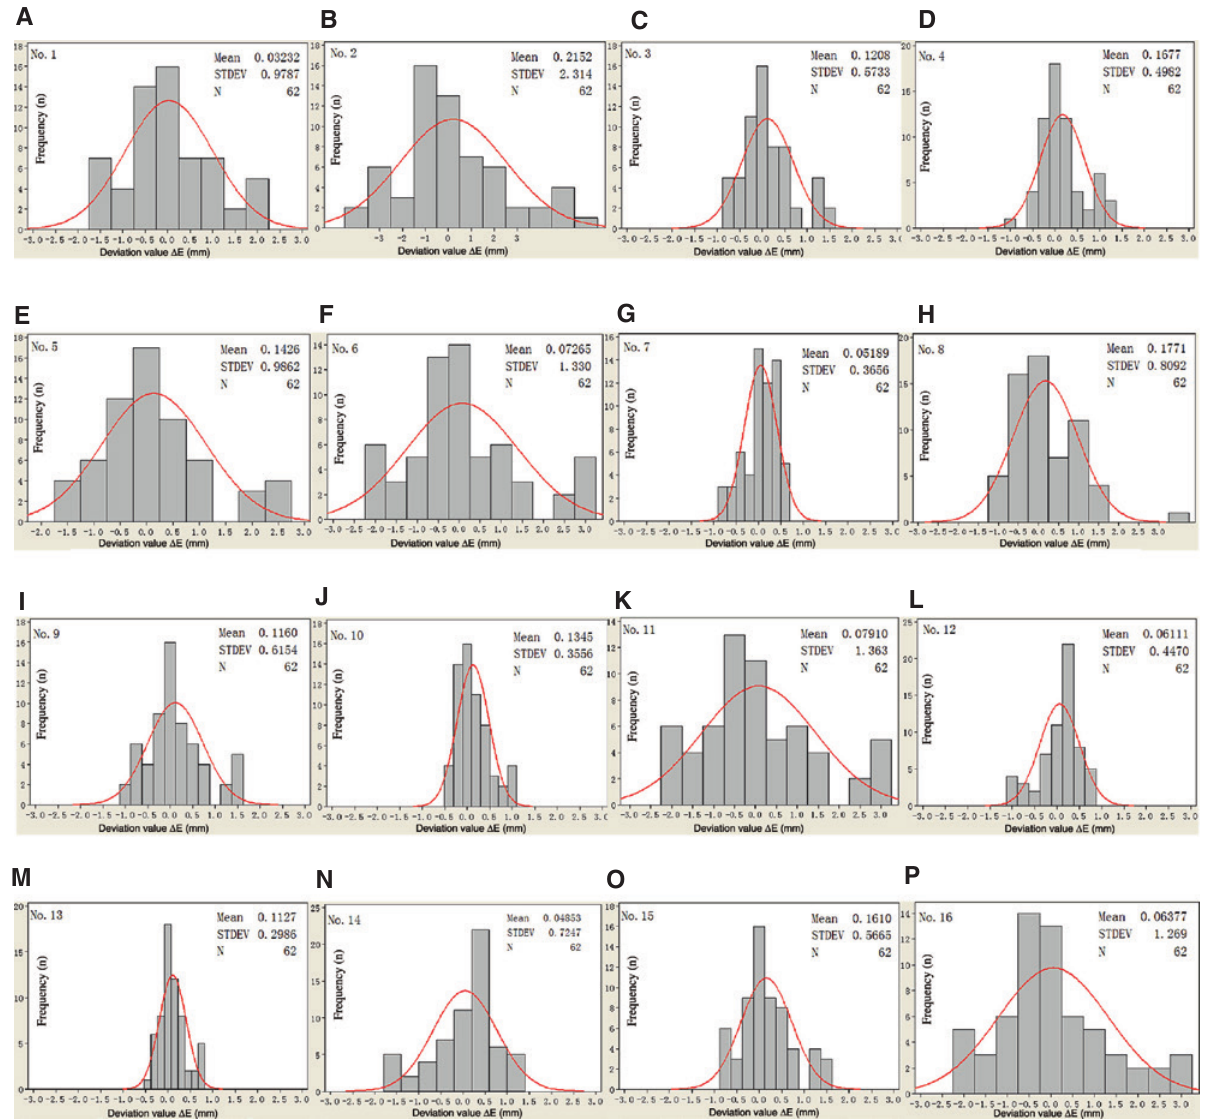
Figure 7: The normal distribution of 16 groups of experiment schemes data points: (A) scheme 1, (B) scheme 2, (C) scheme 3, (D) scheme 4, (E) scheme 5, (F) scheme 6, (G) scheme 7, (H) scheme 8, (I) scheme 9, (J) scheme 10, (K) scheme 11, (L) scheme 12, (M) scheme 13, (N) scheme 14, (O) scheme 15, (P), and scheme